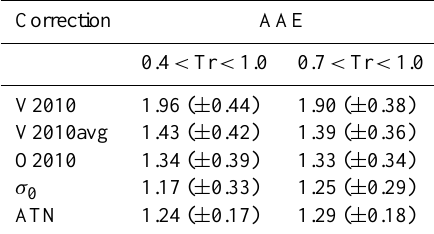
Figure 6. Simulation of the impact of SAE on the AAE calculated using different correction algorithms. The impact on the AAE was used assuming an AE of 1 when σ 0 was 10Mm − 1 at 530nm. The upper panel (a) shows the ratio between the AE of σ 0 and the AAE calculated using O2010 correction. The lower panel (b) shows the ratio between AAE derived using the V2010avg and the O2010 cor- rections. Table 1. AAEs calculated from the Elandsfontein data using differ- ent correction algorithms, σ 0 and ATN. The values in the parenthe- sises represent the AAE standard